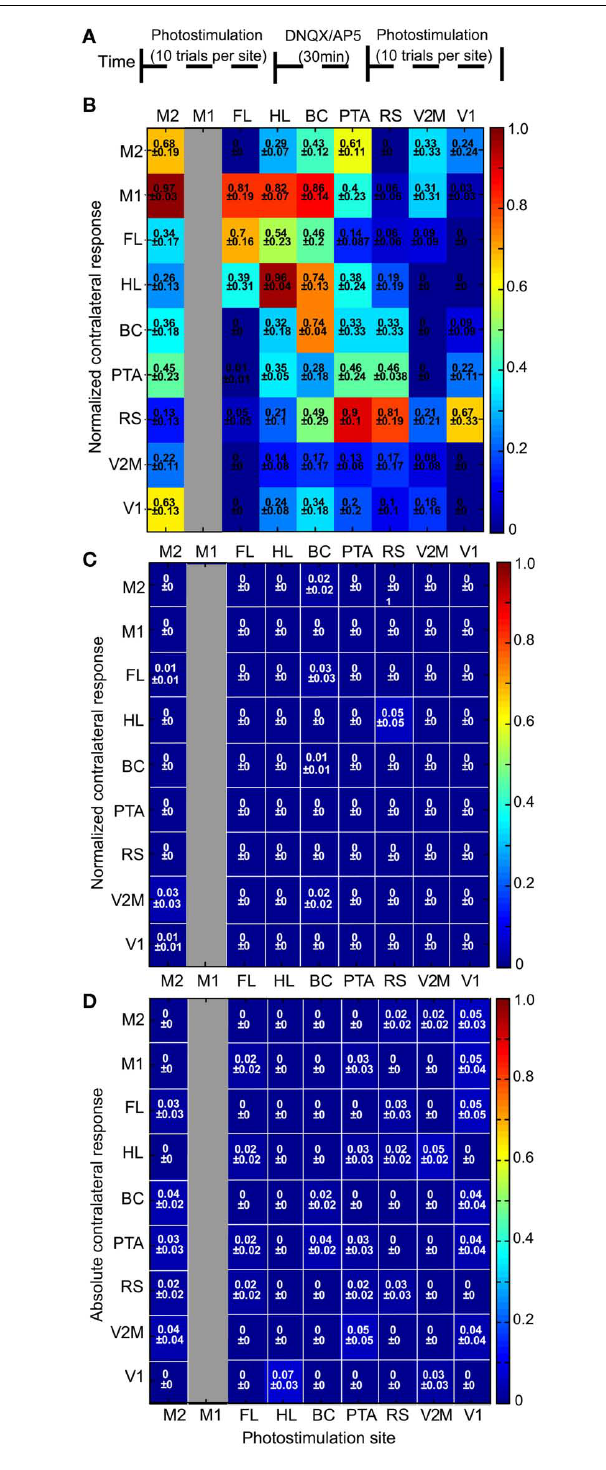
FIGURE 6 | Channelrhodopsin-2 -evokedVSD responses are dependent on intracortical synaptic transmission and ChR2. (A) Schematic showing the experimental timeline for pharmacological blockade of intracortical transmission. (B) Connectivity matrix showing normalizedVSD responses before antagonist application. (C) Connectivity matrix showingVSD